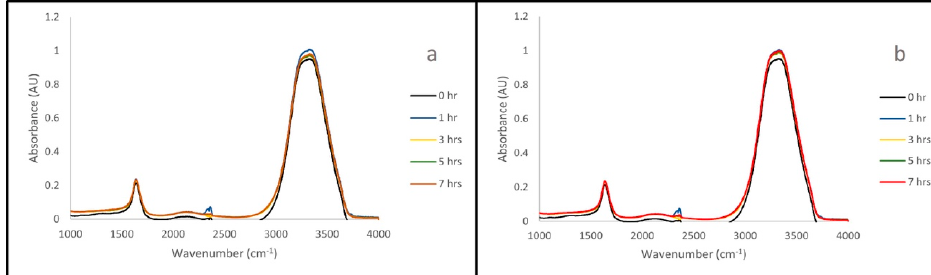
Figure 1. IR Time Lapse of B with 0.01 M HCl ( a ) and 0.01 M NaOH ( b ). Zero, one-, three-, five- and seven-hour IR time lapse of polymer B with exposure to 0.01 M HCl ( a ) and 0.01 M NaOH ( b ). The overlay of the spectra suggests that the polymer does not significantly degrade over the course of exposure.